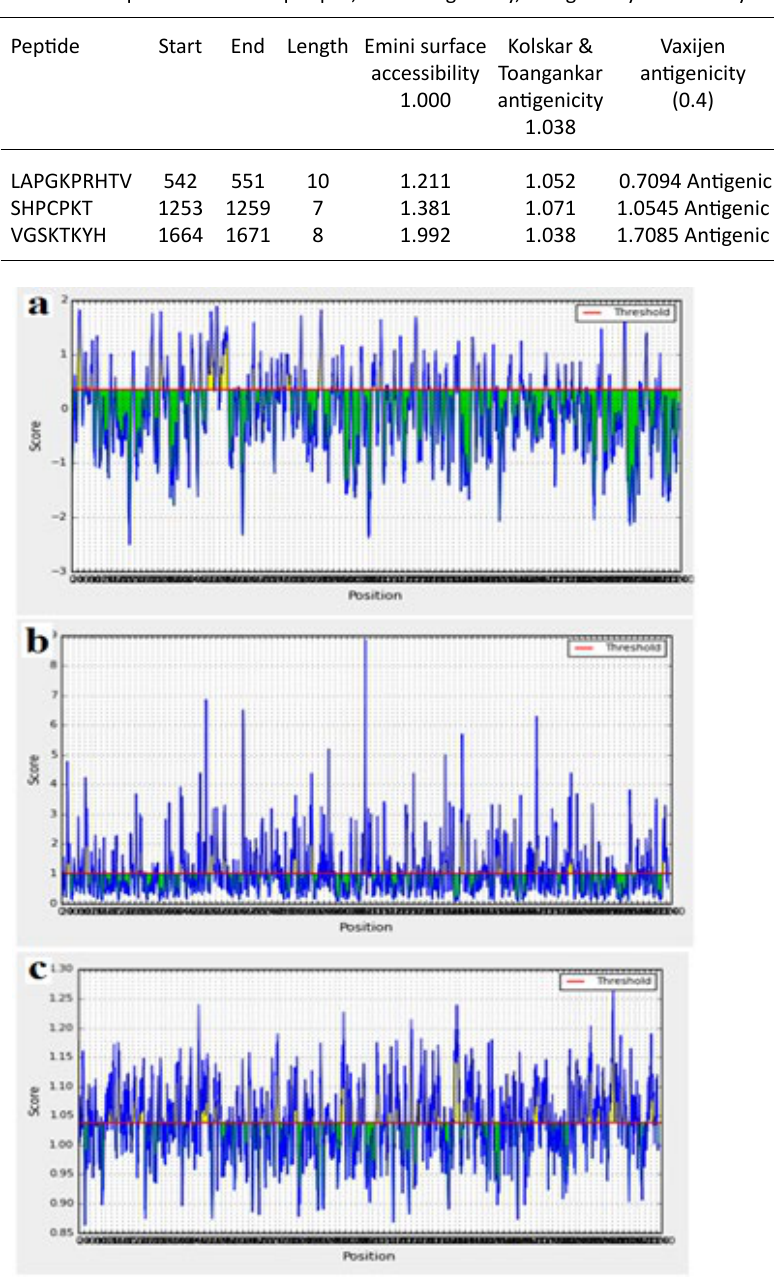
Fig. 2. A- Bepipred linear epitope prediction , B- Emini surface accessibility and C- Kolaskar and Tongaonkar antigenicity prediction. The threshold for each tool was shown by red